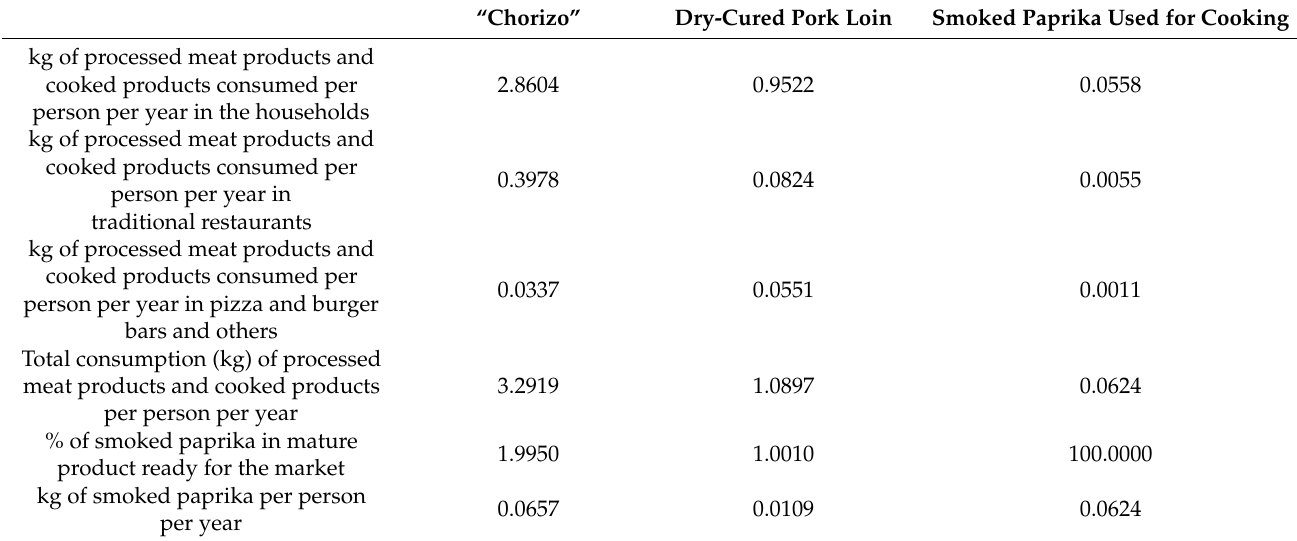
Table 2. Average consumption of smoked paprika in households and restaurants derived from the consumption of processed meat products and food cooked using smoked